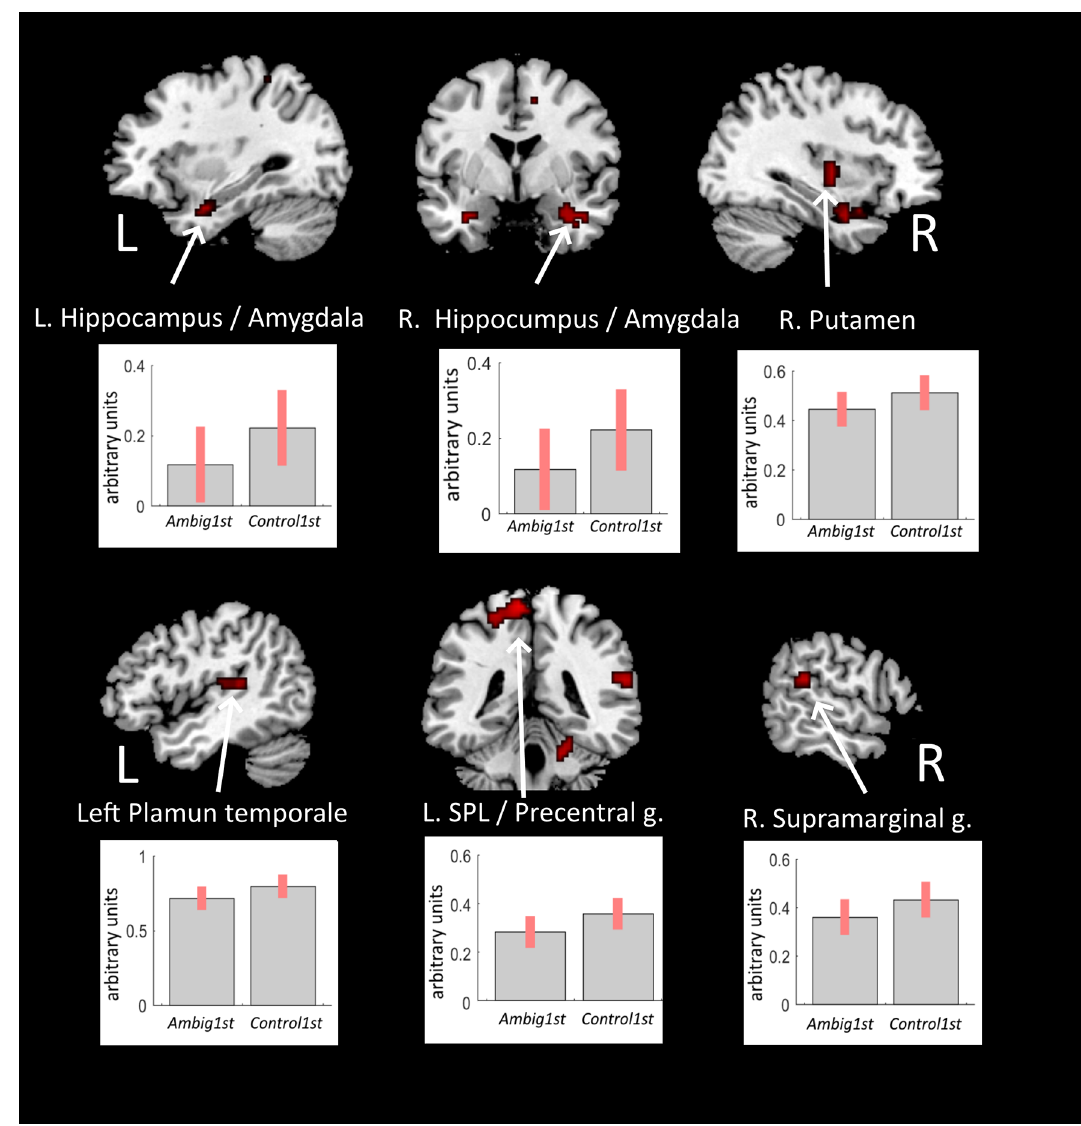
Figure 2. Changes in the BOLD signal associated with processing of non-selected solutions for the word pair fragments. Clusters of significant t-contrast Control1st > Ambig1st presented over a template brain